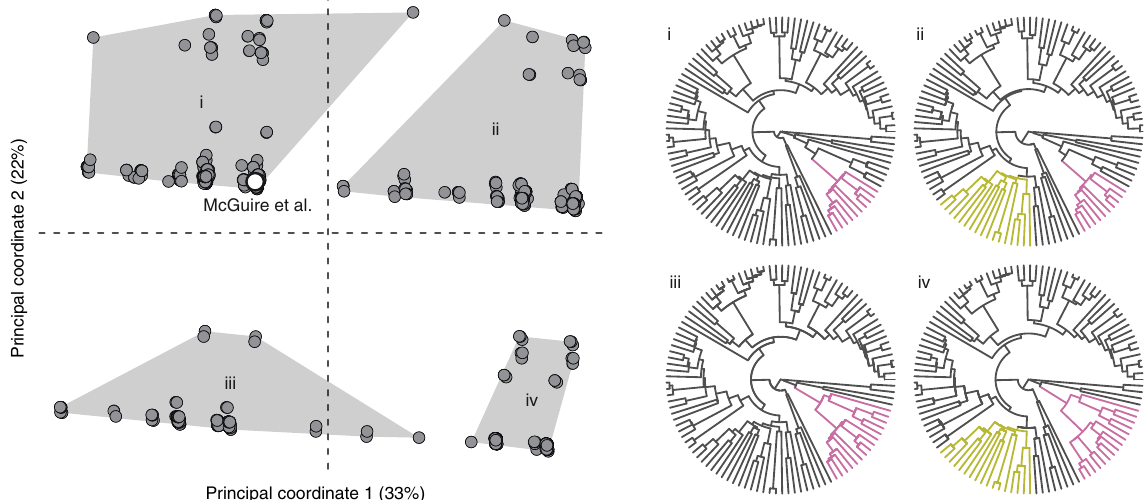
Fig. 2 Uncertainty in phylogenetic relationships among species in this study. The variability in tree topology and branch length is mapped to a reduced- dimensional Euclidean space 35, 36 . The majority (55%) of uncertainty in species relationships is presented by two principal coordinates (PCs). Individual trees are shown by fi lled circles and clustered by similarity. To interpret the variability represented by the two PCs, we compare the median tree corresponding to each cluster (i – iv) to to the Maximum Clade Credibility (MCC) tree of McGuire et al. 20 The principal clade differences between the cluster median trees and the MCC are coloured in i – iv according to the scheme in Fig. 1. This method reveals that among species in this study (not hummingbirds overall), phylogenetic uncertainty primarily represents ambiguities in the Hermit and Brilliant clades. We allow for this uncertainty